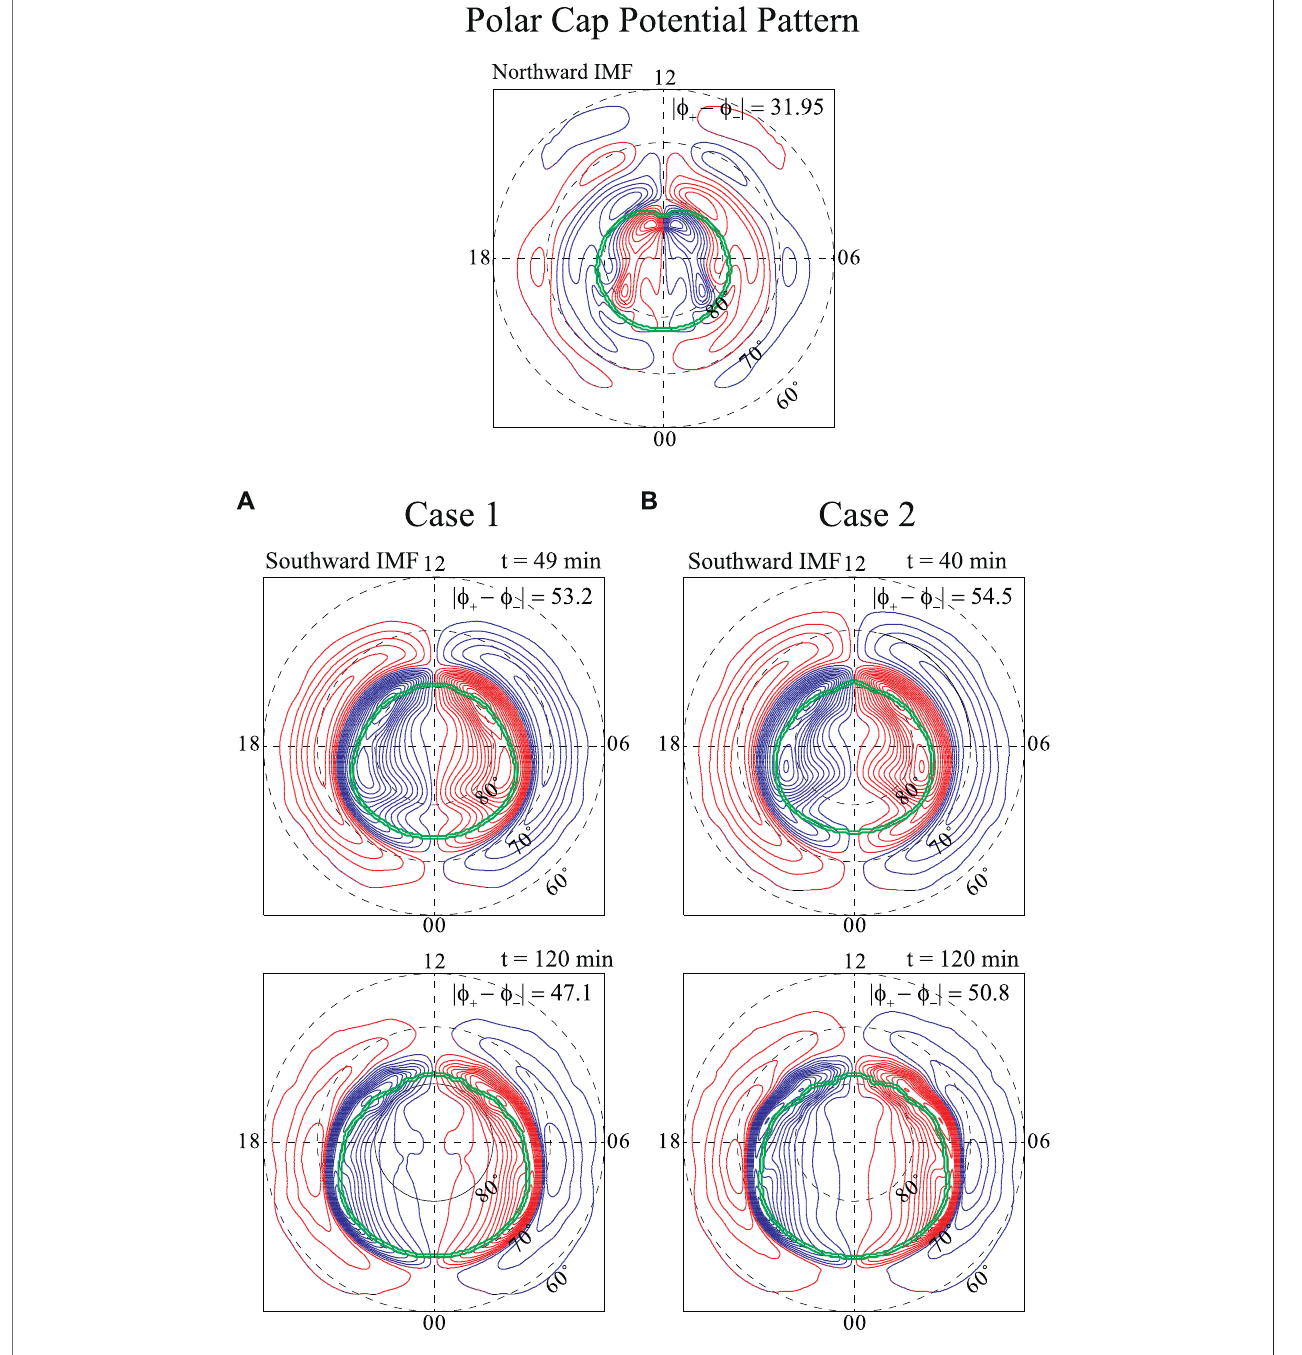
FIGURE 7 | 2D electric potential pattern in the polar region at selected times. The blue and red contours indicate negative and positive potentials, respectively. A double green lines delimit the open-closed fi eld lines boundary.